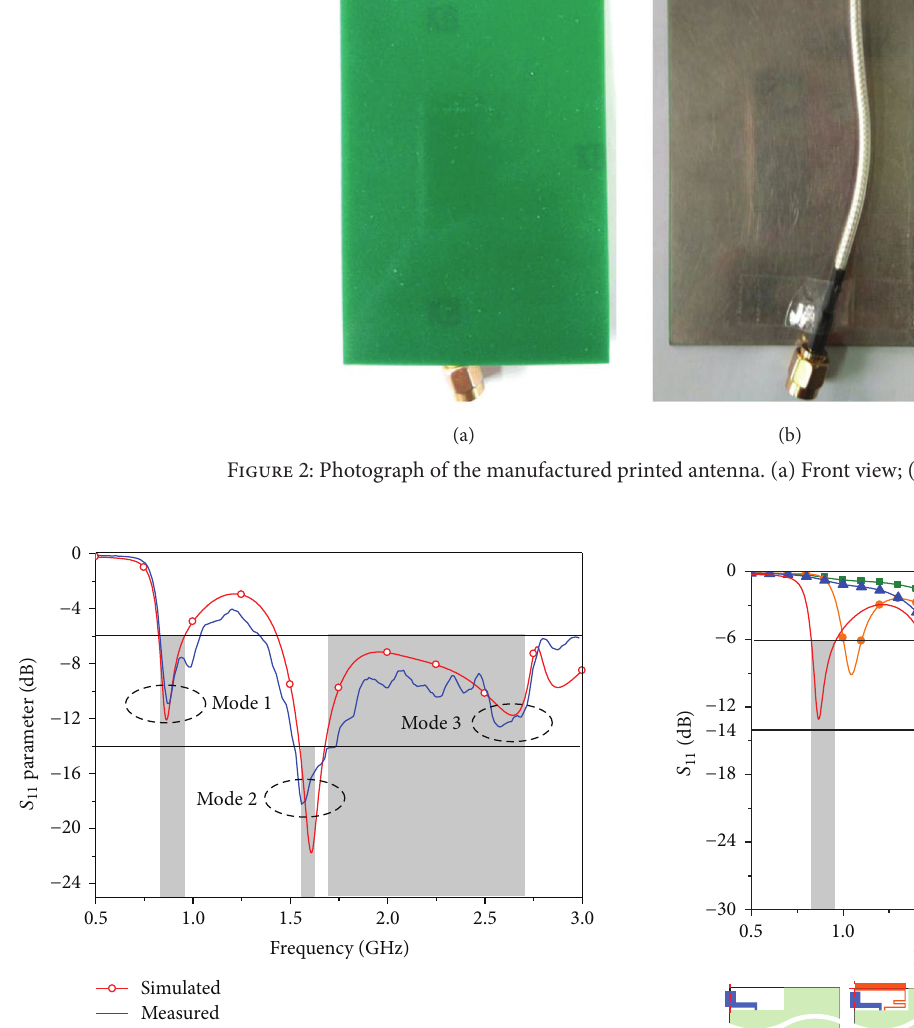
Figure 3: The measured and simulated return loss of the antenna. frequency resonant modes but cannot cover the target bands.